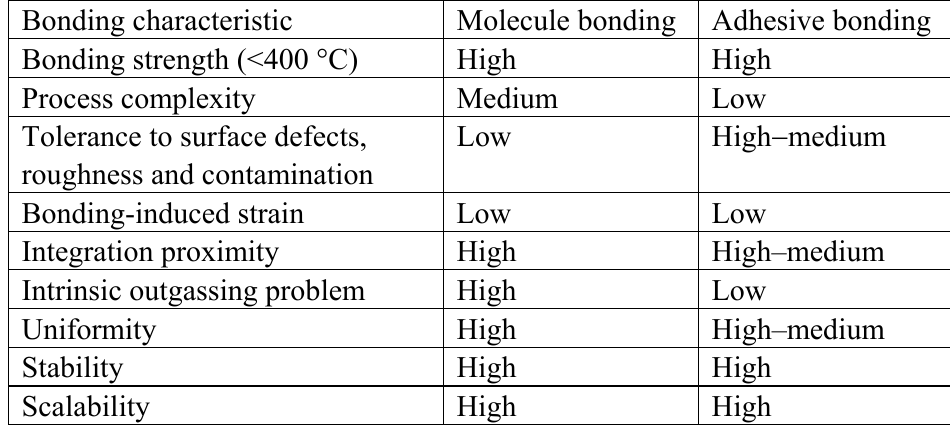
Table 1. Basic bonding characteristic of direct bonding and adhesive bonding. Bonding